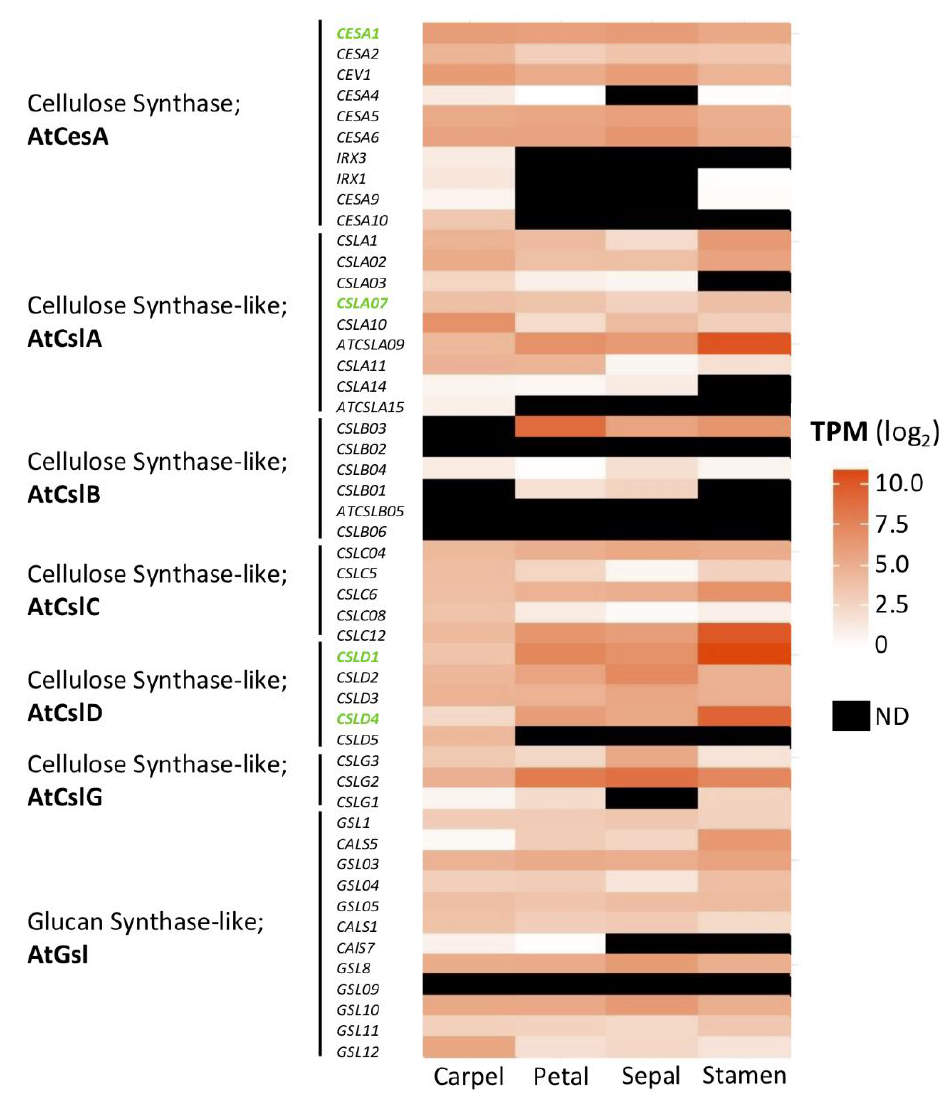
Figure 2. Expression of cell wall biosynthesis genes in Arabidopsis floral tissues. List of genes belonging to the cell wall biosynthesis family (TAIR database). Orange scale color indicates gene expression levels in floral tissues; white color indicates no expression, and black no data (ND). Values indicate log2-transformed transcripts per million (TPM) for each tissue; data from [23]. Gene names in green color mark genes that are functionally characterized.